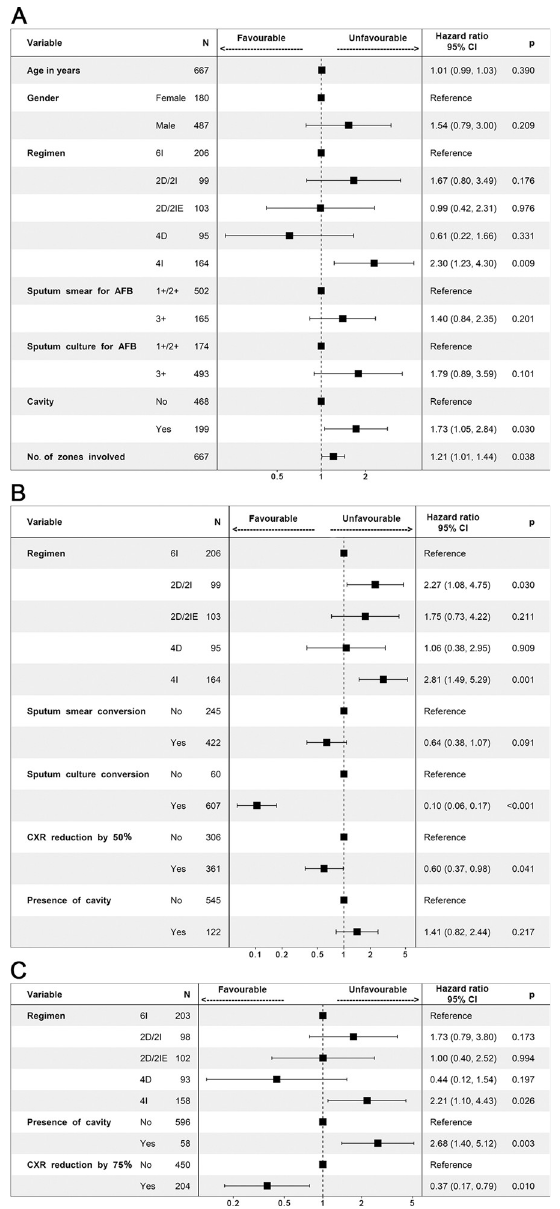
Fig 3. Cox Regression Model depicted in the Forest Plot showing the adjusted hazards ratio (with 95% CI and p value) of radiological and bacteriological parameters at baseline along with demographics (A), at the end of intensive phase of two months (B), at the end of treatment (C). Sample size (n) for A and B was 667, while for C, n was 654, as only recurrences were relevant to be considered at this time point for prediction. The drift towards left and right signifies tendency towards favourable and unfavourable response for each factor studied. Apart from regimen, presence of cavitation and number of zones at baseline, sputum culture conversion and CXR reduction of lesions by 50% at the end of intensive phase, persistence of cavity and CXR clearance of lesion by 75% from end of intensive phase CXR were all significantly influencing TB outcome. N—number, %—percentage, CI–Wald’s confidence interval, p- probability value (significance taken as < 0.05), AFB- acid fast Bacilli, No.—Number, CXR-Chest X-ray Regimens: 4I - 4 months intermittent, 2D/2I - 2 months daily followed by 2 months intermittent, 2D/2IE—2 months daily followed by 2 months intermittent with ethambutol given in continuation phase also, 4D - 4 months daily, 6I - 6 months intermittent (standard of care). All intermittent regimens were administered thrice weekly. Regimen description is provided in the e-Supplement Section